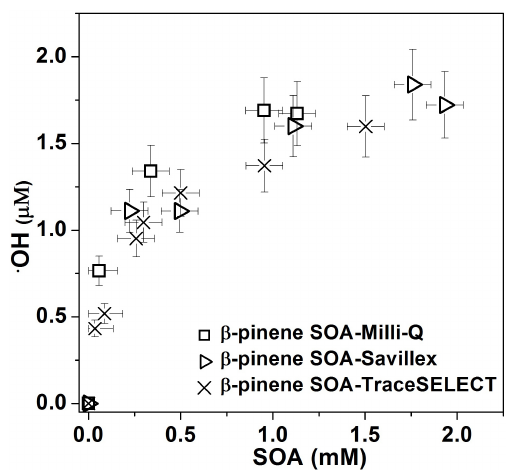
Figure 5. OH yield of β -pinene SOA in three different kinds of pure water: Milli-Q (squares), Savillex (triangles) and TraceSE- LECT (Sigma,